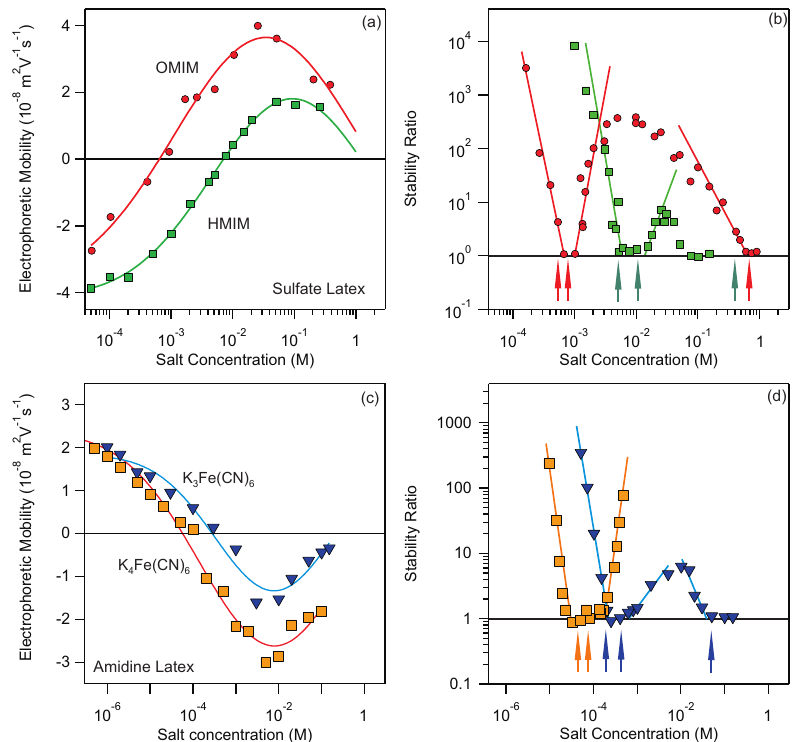
Figure 2. ( a ) Electrophoretic mobility as a function of HMIMCl and OMIMCl concentration for sulfate latex particles. The lines show the interpolating curves used for CCC calculation. ( b ) Stability ratios as a function of HMIMCl and OMIMCl concentration for sulfate latex. Measurements were done at pH 4.0. Data were taken from [35]. The arrows mark the calculated CCC values based on Hamaker constant of 2.0 · 10 − 21 J. The lines connecting the stability data points are eye-guides. ( c ) Electrophoretic mobility as a function of K 3 Fe(CN) 6 and K 4 Fe(CN) 6 concentration for amidine latex particles. The lines show the interpolating curves used for CCC calculation. ( d ) Stability ratios as a function of K 3 Fe(CN) 6 and K 4 Fe(CN) 6 concentration for sulfate latex. Measurements were done at pH 4.0. Data were taken from [50]. The arrows mark the calculated CCC values based on Hamaker constant of 3.0 · 10 − 21 J. The lines connecting the stability data points are